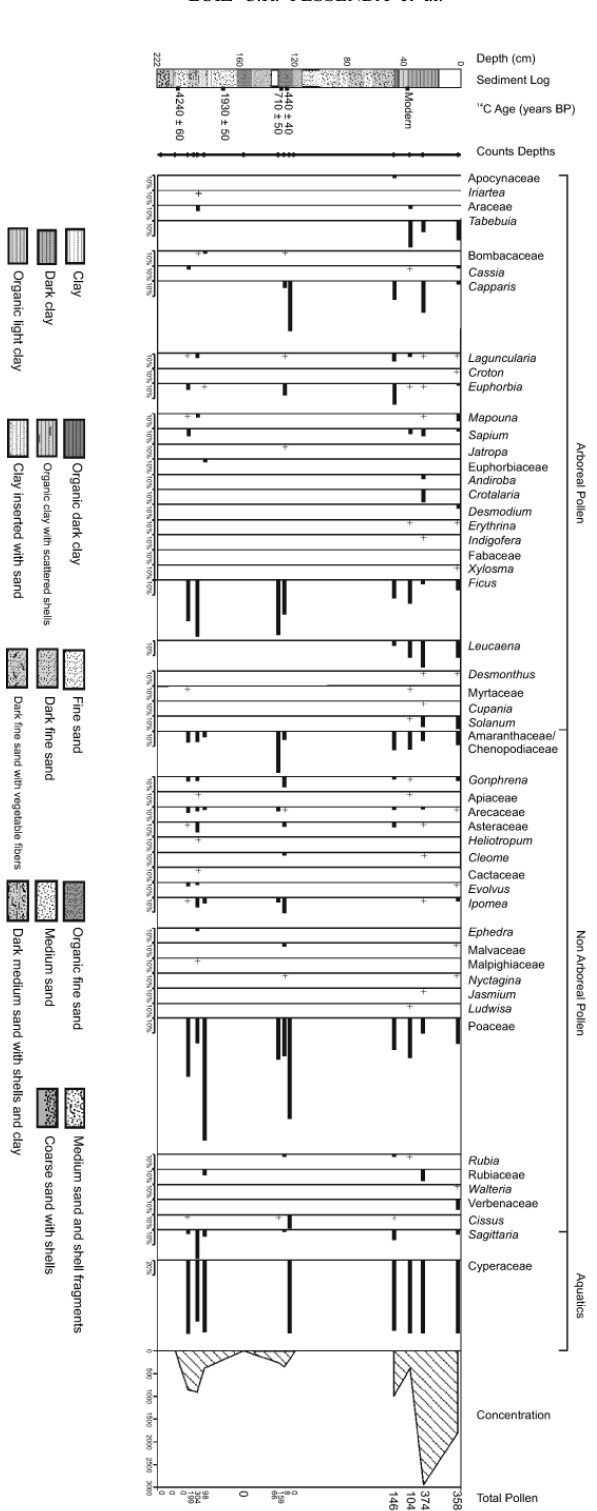
Fig. 6 – Pollen percentage diagram of Manguezal do Sueste showing selected taxa. The pollen sum includes arboreal and non-arboreal pollen taxa. Values smaller than 1% are represented by the “ + ”